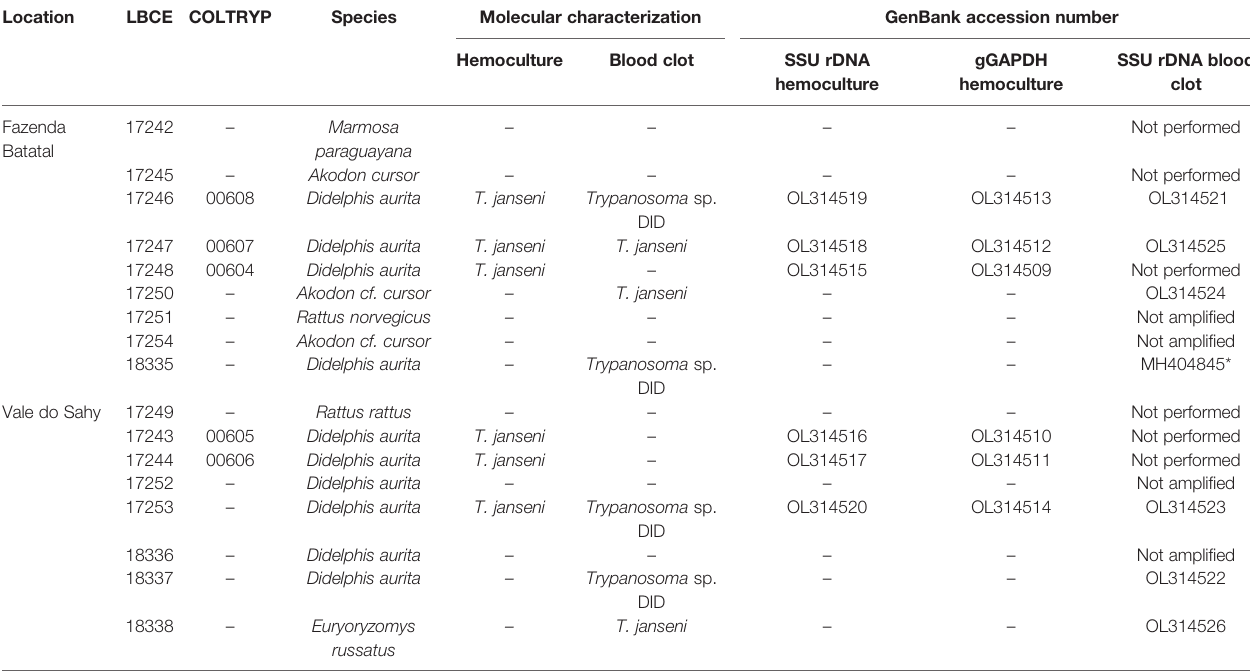
TABLE 1 | Small sylvatic and synanthropic mammals captured and Trypanosoma sp. infection in Mangaratiba municipality, RJ state in 2015.